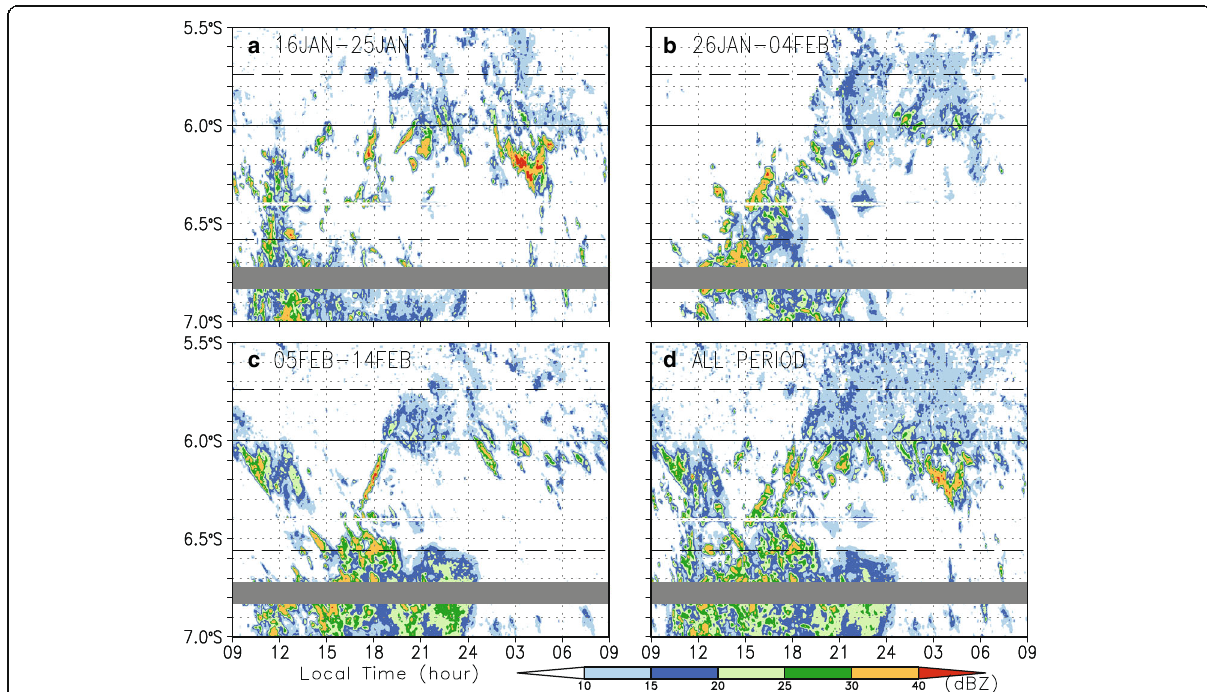
Fig. 8 Diurnal meridional variations of the CDR echo in each period. Same as Fig. 6b but 24-h views of DRMM averaged for the a CENS active, b transition, and c inactive periods, as well as the d whole